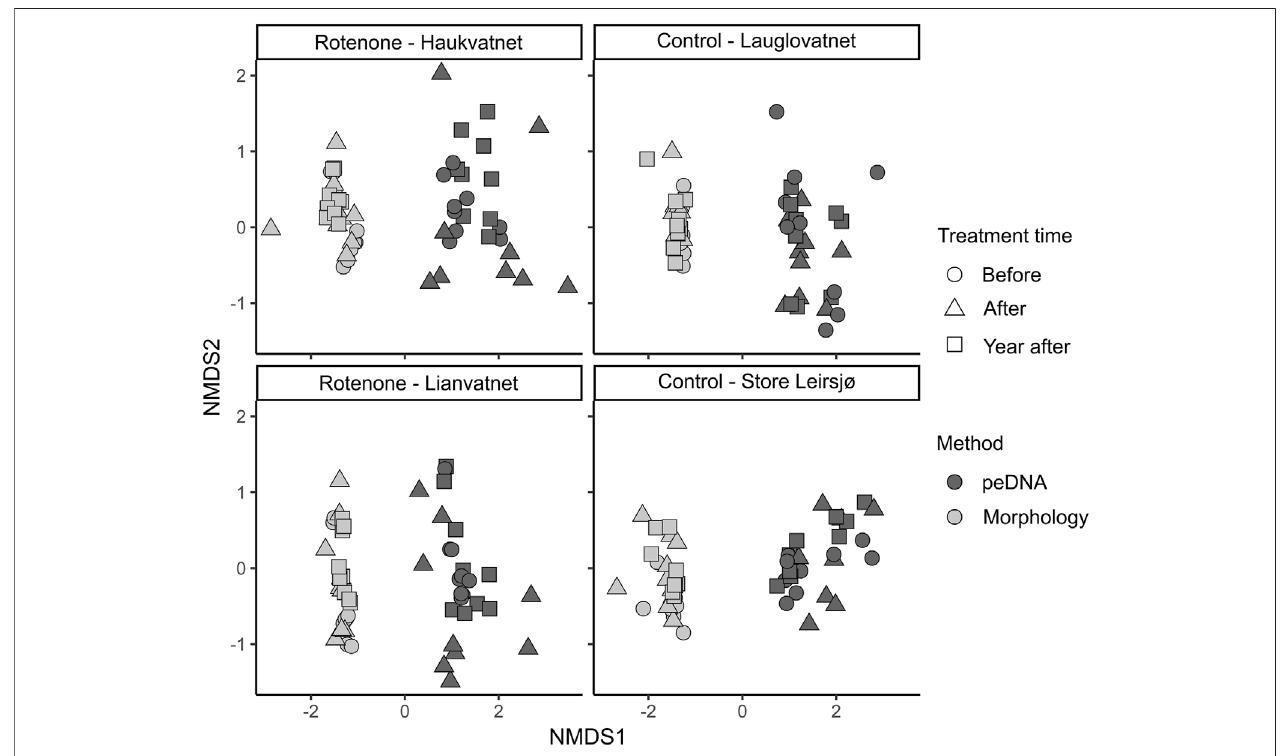
FIGURE 4 | NMDS plot of the same samples identi fi ed by morphology or metabarcoding of peDNA just before, just after and 1 year after the rotenone treatment (Stress = 0.09). Treated lakes are in the left panels and control lakes in the right panels.